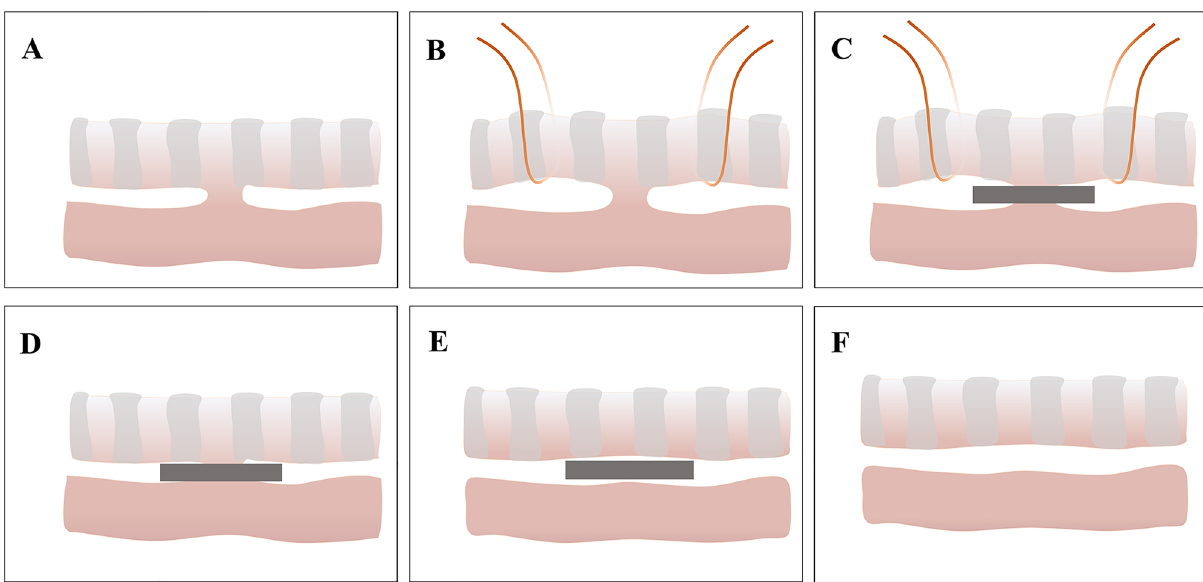
Figure 1. The process of repairing TEF using the magnetic compression technique. ( A ) TEF model formed by the magnetic compression technique. ( B ) The tracheoesophageal space was cleaned and the TEF was exposed. ( C ) The pressing magnet was placed in the tracheoesophageal space. ( D ) The pressing magnet continued to press the fistula in vivo until both sides were healed. ( E ) After the two sides were healed, the pressing magnets were separated from the tissue. ( F ) After removing the pressing magnets, the TEF was